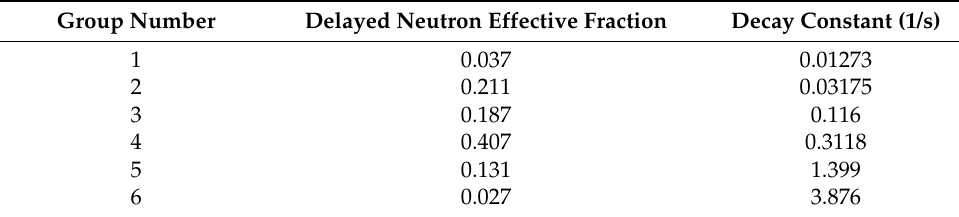
Table 2. Neutron physical parameters in the KRUSTY